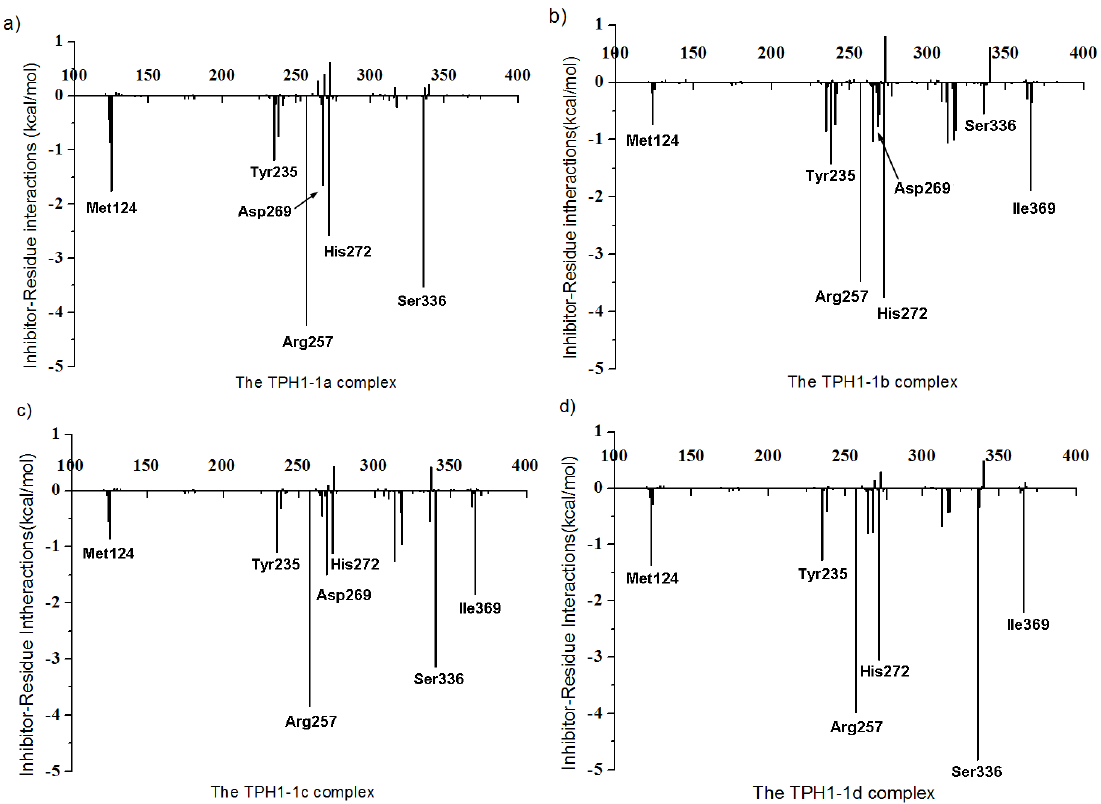
Figure 8. Decomposition of the binding free energies on a per-residue basis for the TPH1-1a ( a ), TPH1-1b ( b ), TPH1-1c ( c ) and TPH1-1d ( d